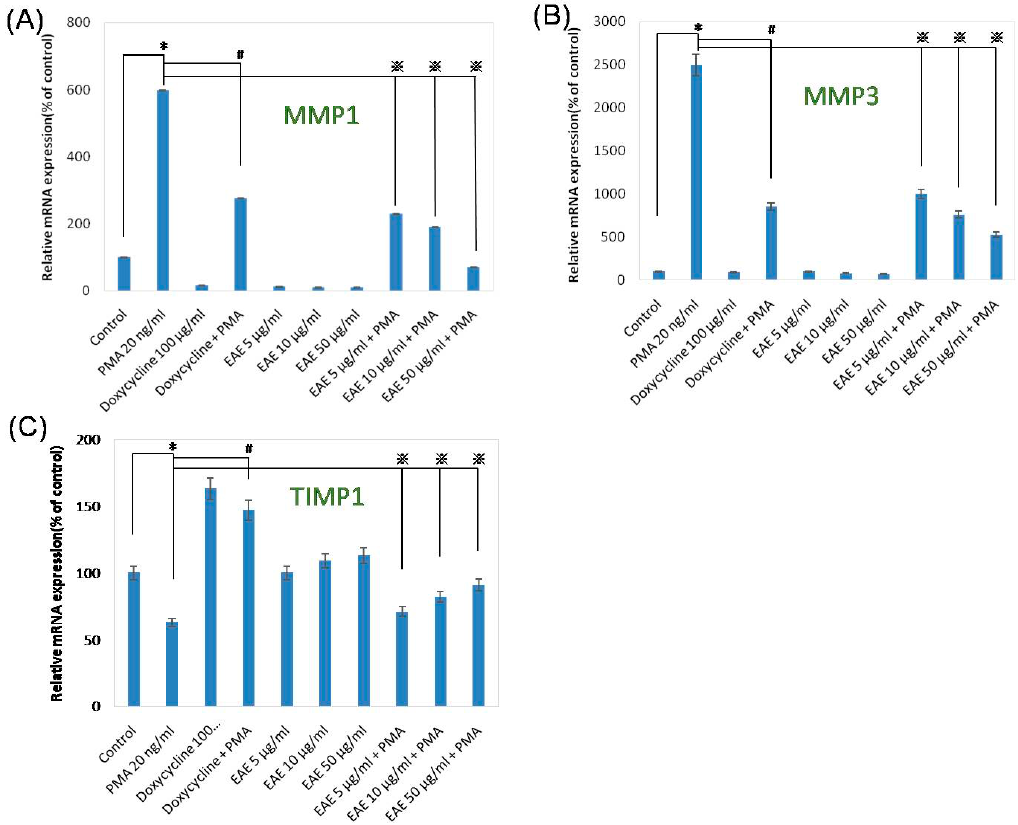
Figure 4. Human normal epidermal fibroblasts collagen production with EAE treatments in sirius red assay. In ( A ) Day 1, at 50 μ g/mL; ( B ) Day 7, at 50 μ g/mL; and ( C ) PMA, at 20 ng/mL treated 24 h. Sirius emitted bright red color (microscopy, the magnification is 100×); ( D ) Day 1 and ( E ) Day 7 have been quantitative; ( F ) Anti-oxidative effect of EAE in PMA-activated fibroblast viability. (Data represents mean ± S.D. of three independent experiments performed. * p < 0.01, # p < 0.01 and ※ p < 0.01).